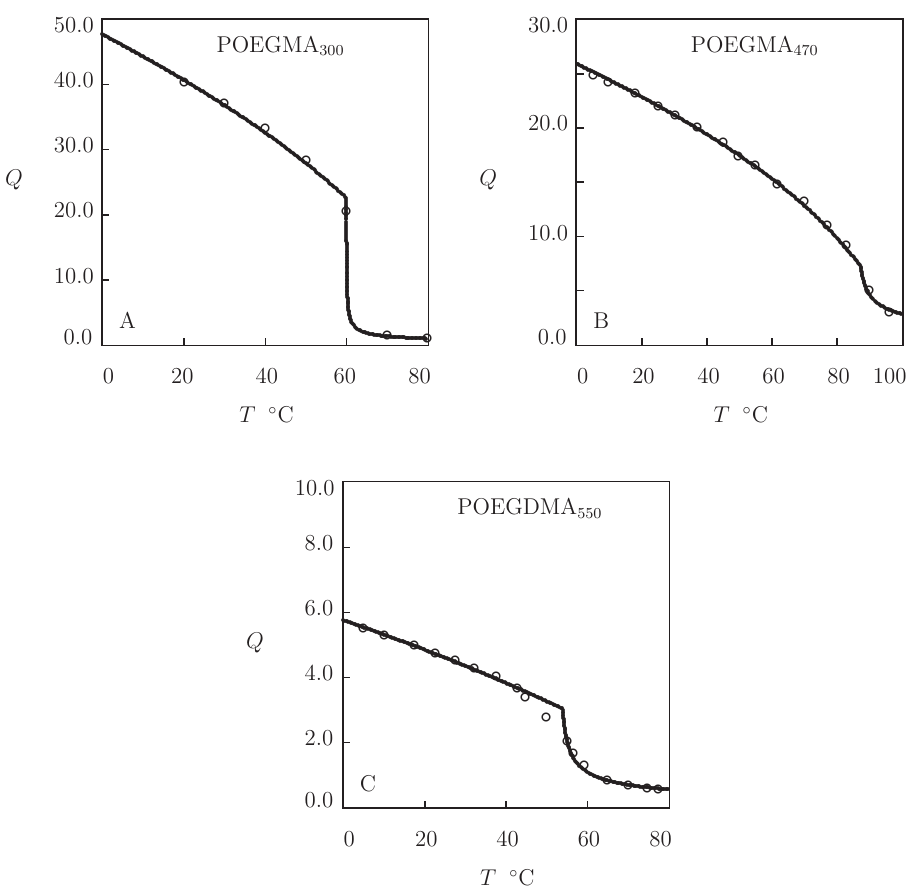
Figure 11. Degree of swelling Q versus temperature T . Circles: experimental data (( A ) POEGMA 300 gel [105], ( B ) POEGMA 470 nanocomposite gel [104], and ( C ) POEGDMA 550 gel [106]). Solid lines: results of